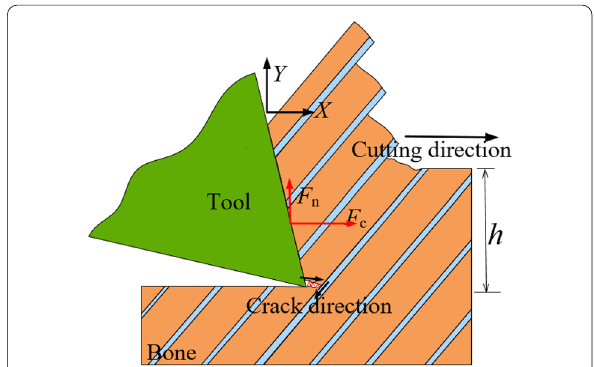
Figure 3 Cutting model in mode #2